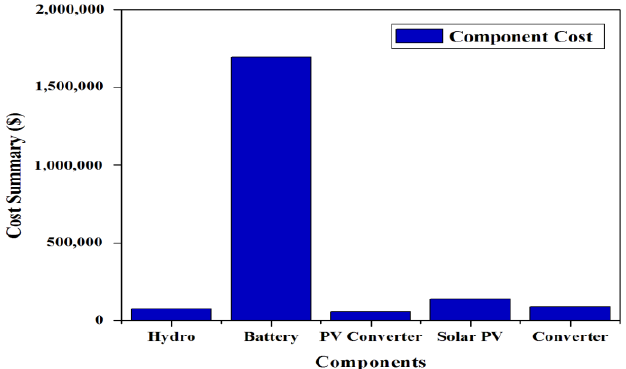
Figure 21. Total component cost breakdown for case III (Ba/H/S).